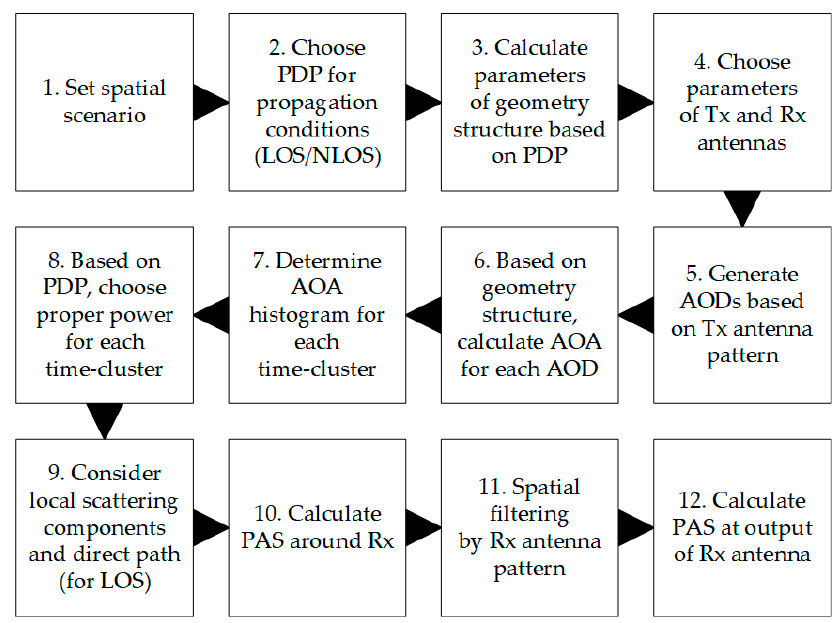
Figure 2. Simplified simulation procedure of the MPM.